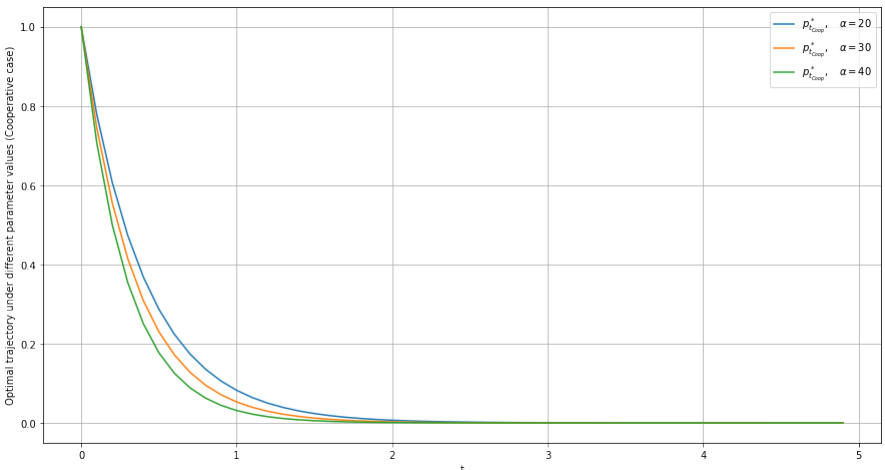
Figure 9. The optimal trajectory of pollution stock under cooperative scenario and different α